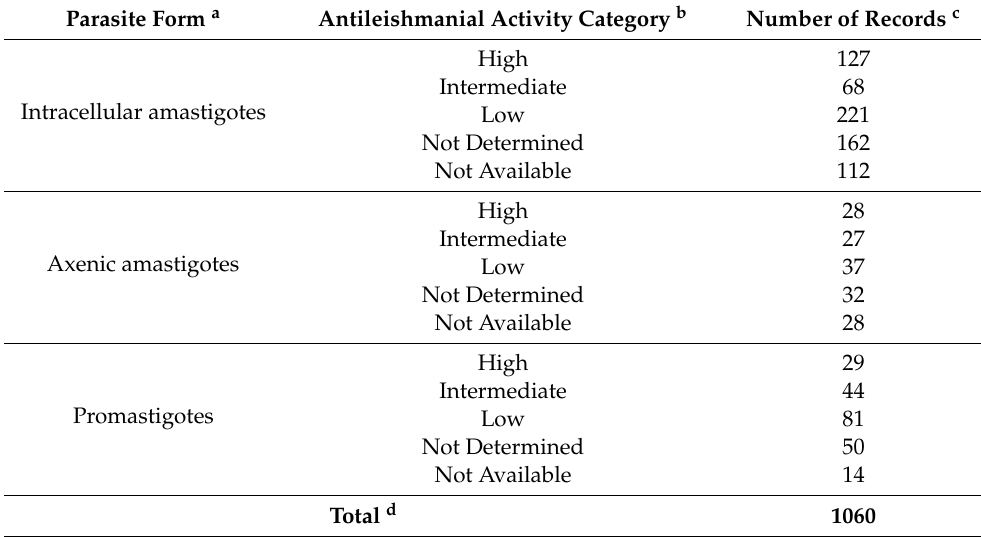
Table 2. Summary of antileishmanial activity of those compounds retrieved from the articles included in this systematic